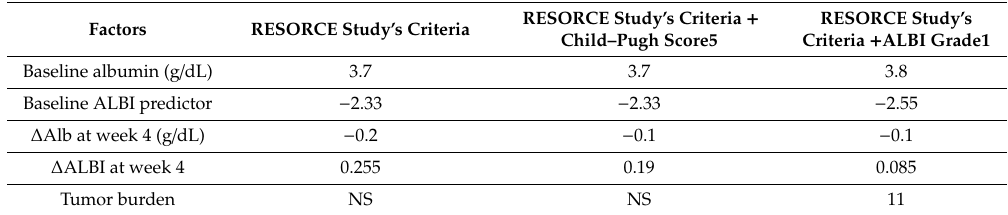
Table 5. The cut-o ff value of factors to fulfill various conditions at the time of radiological progressive